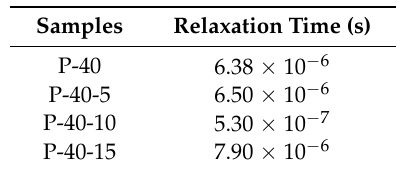
Figure 3. ( a ) Variation of loss tangent with frequency for P-40, P-40-5, P-40-10, and P-40-15. ( b ) Stress-strain curves of pure PVA, P-40, and P-40-10 films (insets show photographs of the films) recorded at room temperature. Table 1. Values of relaxation time for the